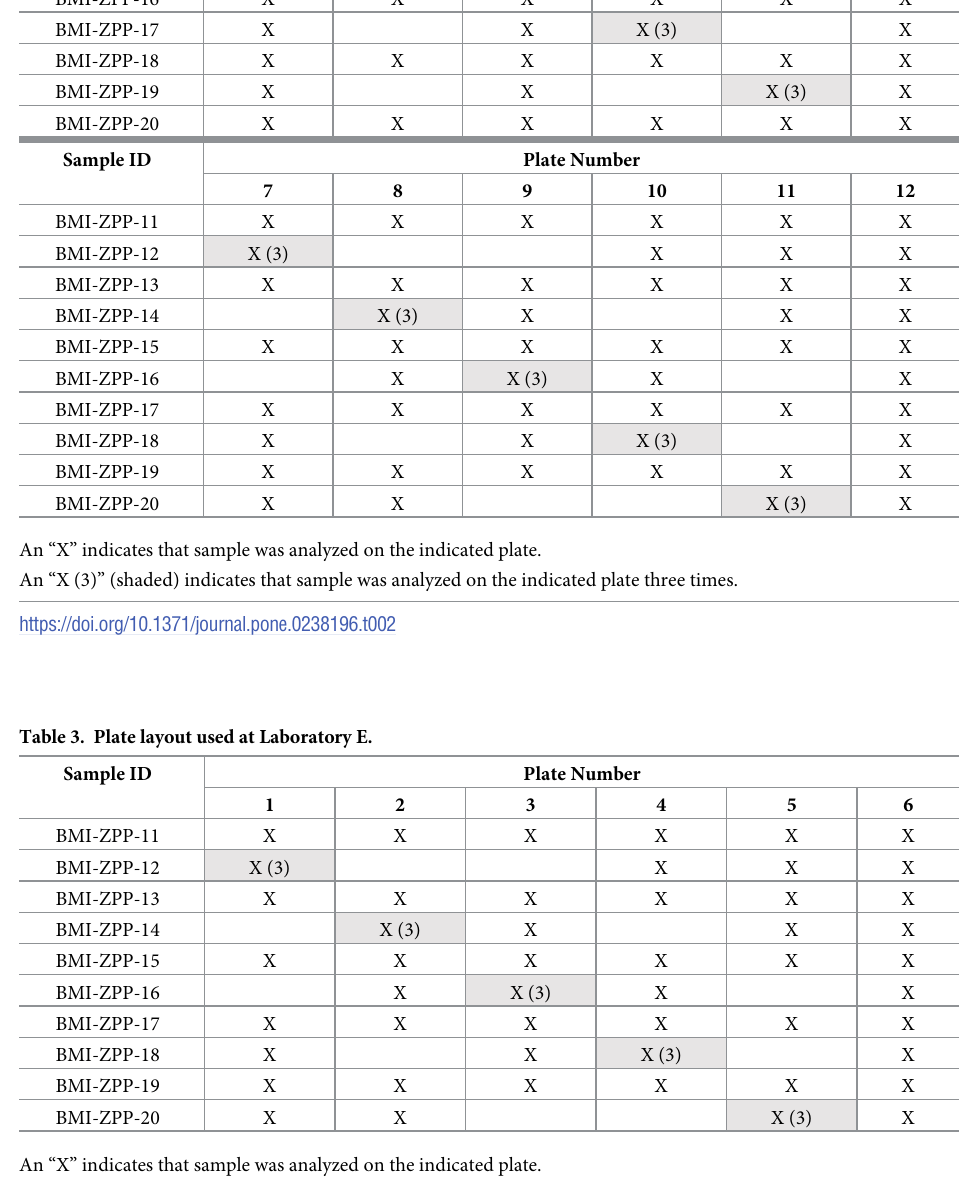
An “X” indicates that sample was analyzed on the indicated plate. An “X (3)” (shaded) indicates that sample was analyzed on the indicated plate three